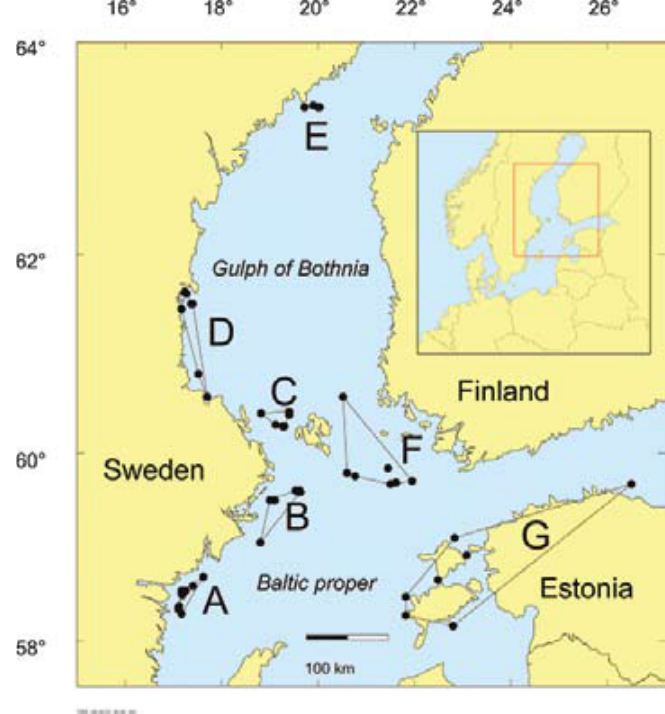
Fig. 2. Study area in the Baltic Sea, with sites grouped into subareas for